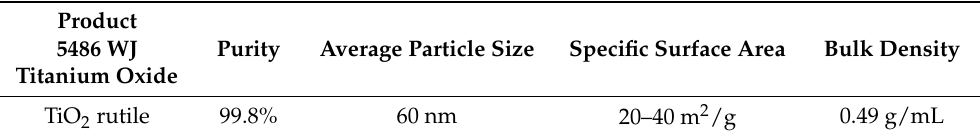
Table 2. Quantitative analysis of the results (RIR) .